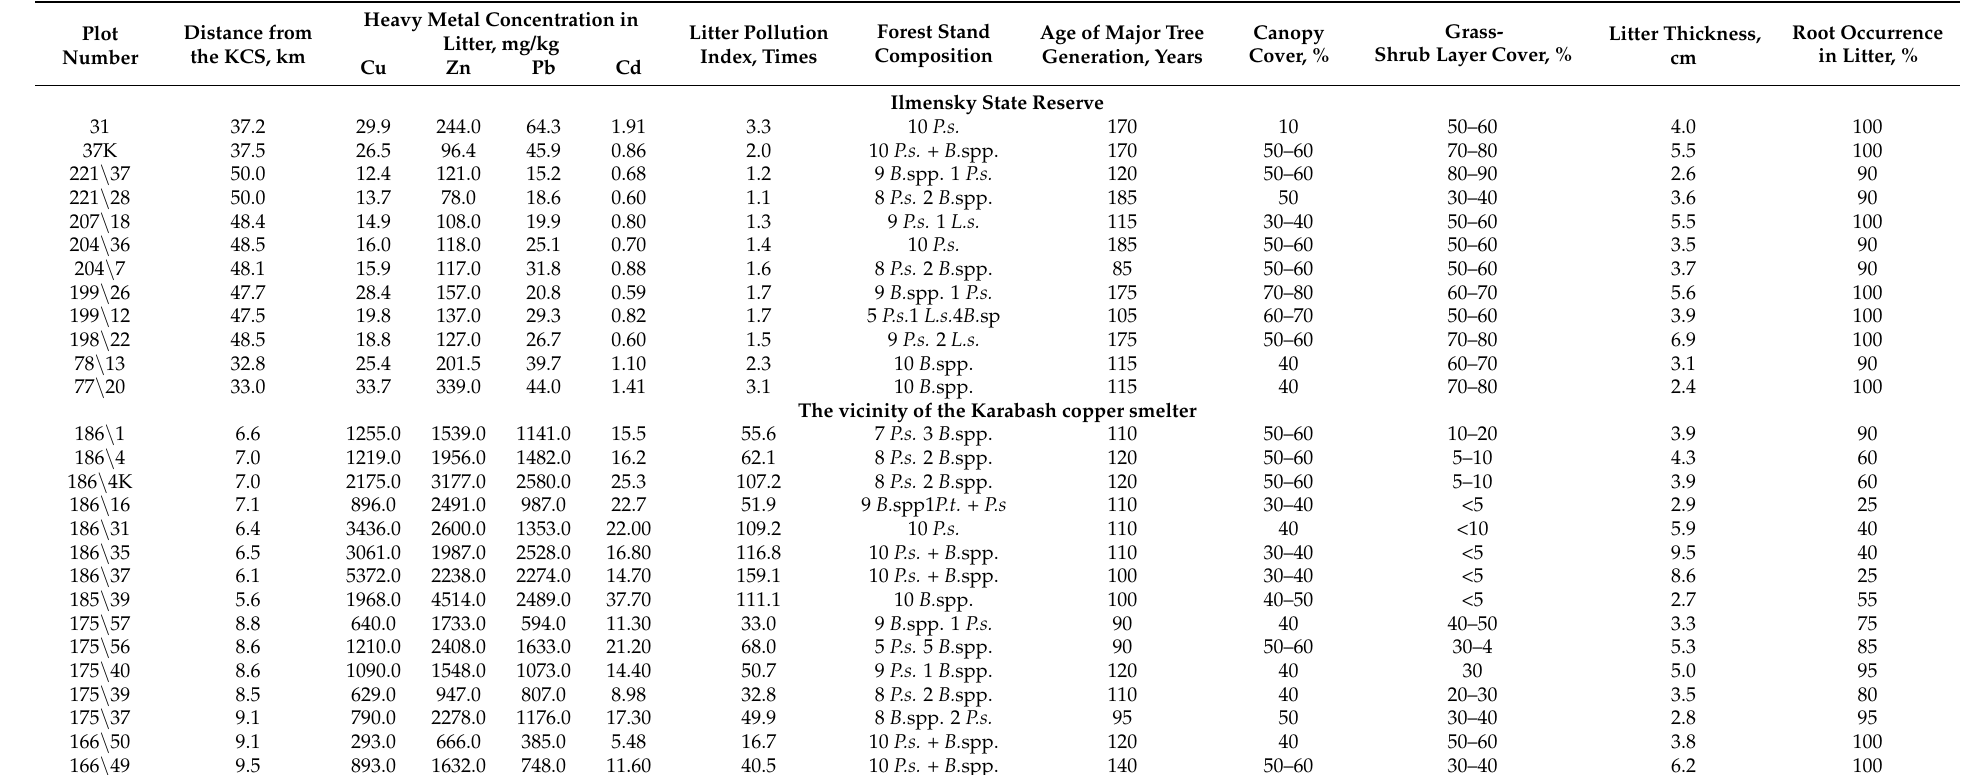
Table 1. Sample plot characteristics